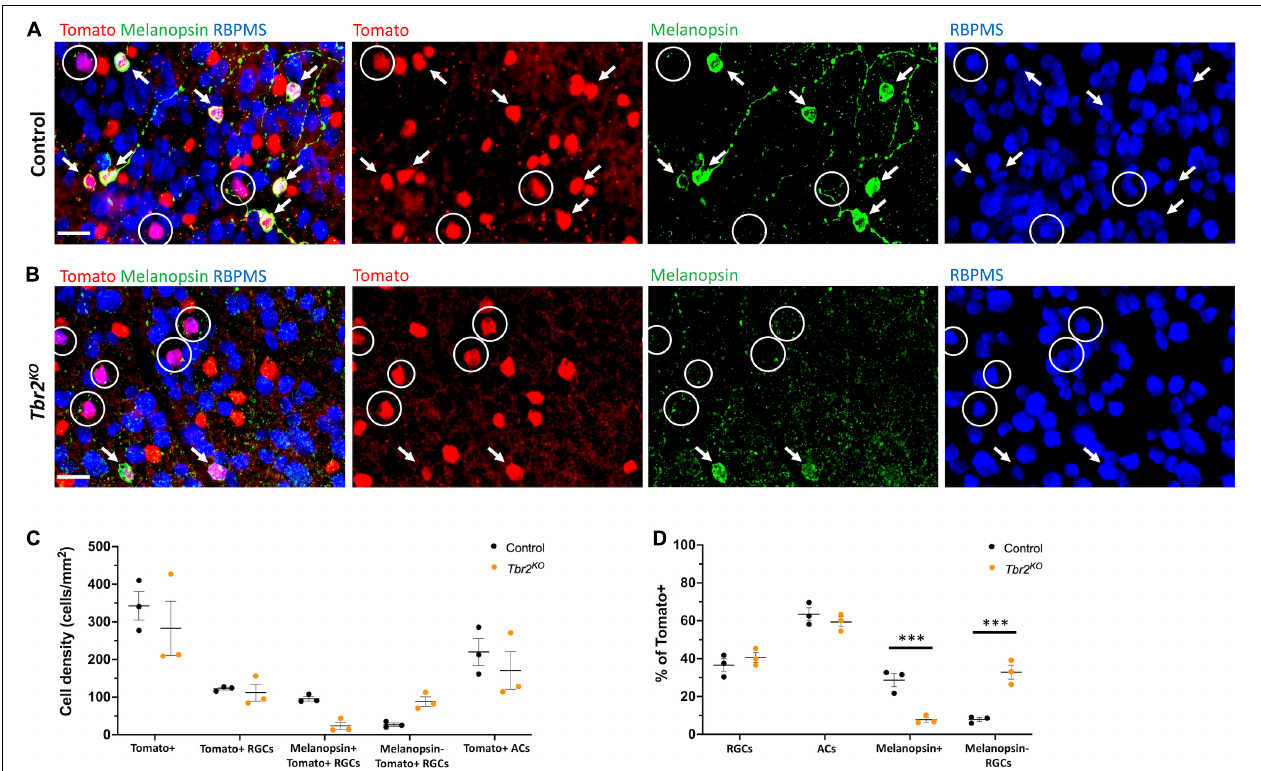
FIGURE 2 | Loss of Tbr2 in adulthood results in loss of melanopsin expression but not cell death of Tomato + RGCs. (A) Flatmounted control ( Tbr2 CreER / + ;tdT ) retina (GCL side up) immunostained to reveal expression of Tomato (red), melanopsin (green), and RBPMS (blue); circled cells are Tomato + RGCs that do not express melanopsin, arrows point to melanopsin + Tomato + RGCs, scale bar = 25 µ m. (B) Flatmounted Tbr2 KO ( Tbr2 CreER / flox ;tdT ) retina immunostained to reveal expression of Tomato (red), melanopsin (green), and RBPMS (blue); circled cells are Tomato + RGCs that do not express melanopsin, arrows point to melanopsin + Tomato + RGCs. Tomato + cells lose melanopsin expression. (C) Quantification of cell densities (cells/mm 2 ) of different cell populations in control and Tbr2 KO mice ( n = 3 mice in each group; each dot represents the sum of four fields of view (FOVs) for 1 retina; mean ± SEM displayed; two-way ANOVA with Sidak’s multiple comparisons test; no significant differences). (D) Quantification of the percentages of Tomato + cells that belong to cell populations of interest in control and Tbr2 KO mice ( n = 3 mice in each group; each dot represents the percentage for 4 summed FOVs of 1 retina; mean ± SEM displayed; two-way ANOVA with Sidak’s multiple comparisons test; *** P <